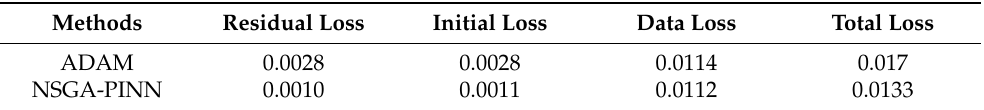
Table 2. Inverse pendulum problem with data noise: each loss value from NN trained by different training methods with noisy data.